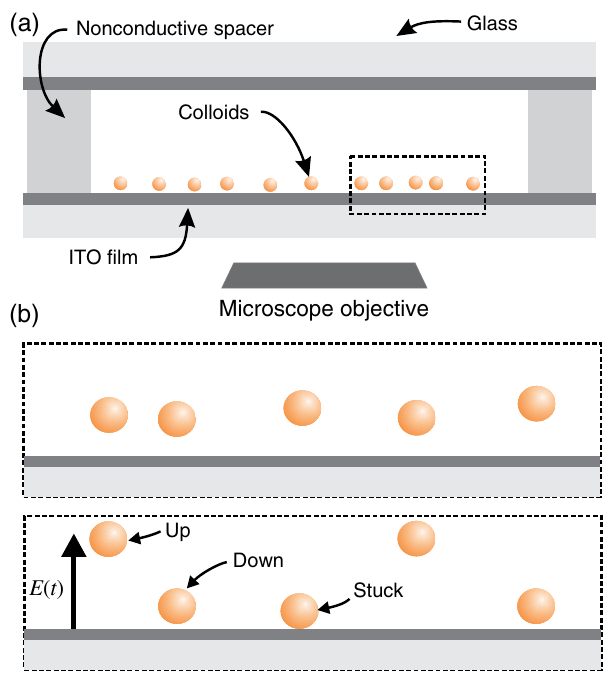
FIG. 1. (a) Schematic of the experimental apparatus (not to scale). (b) Schematic indicating particle heights before and after application of the electric field (top and bottom, respectively). Note that three possible heights occur: “ up, ” “ down, ” and “ stuck ” (i.e., irreversibly adhered to the indium tin oxide ( 15 Ω sheet resistance) separated by a 1-mm-thick nonconductive polydimethylsiloxane (PDMS) spacer (Fig. 1). A number of different particles are tested: 2 - μ m-diameter fluorescent sulfated polystyrene (PS) (Invitrogen, USA), 2 μ m aliphatic amine PS (Invitrogen,